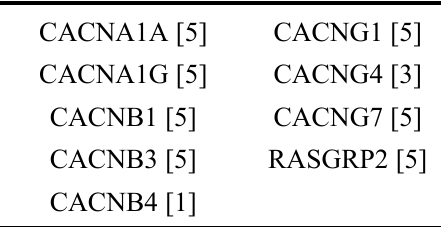
Table 2. Voltage-dependent calcium channel MCODE